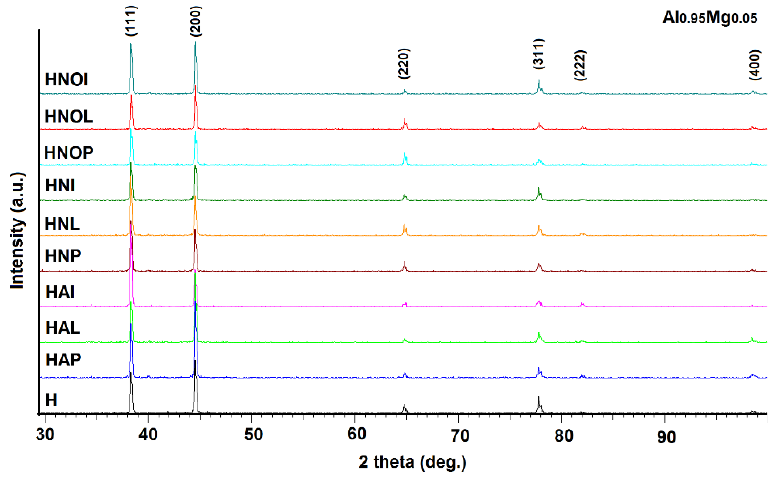
Figure 8. Appearance of X-ray diffractograms of 5083 aluminum alloy samples after heat treatment at different temperatures and maintenance times. Table 4. Elemental cell parameters and crystallite size of the analyzed samples.